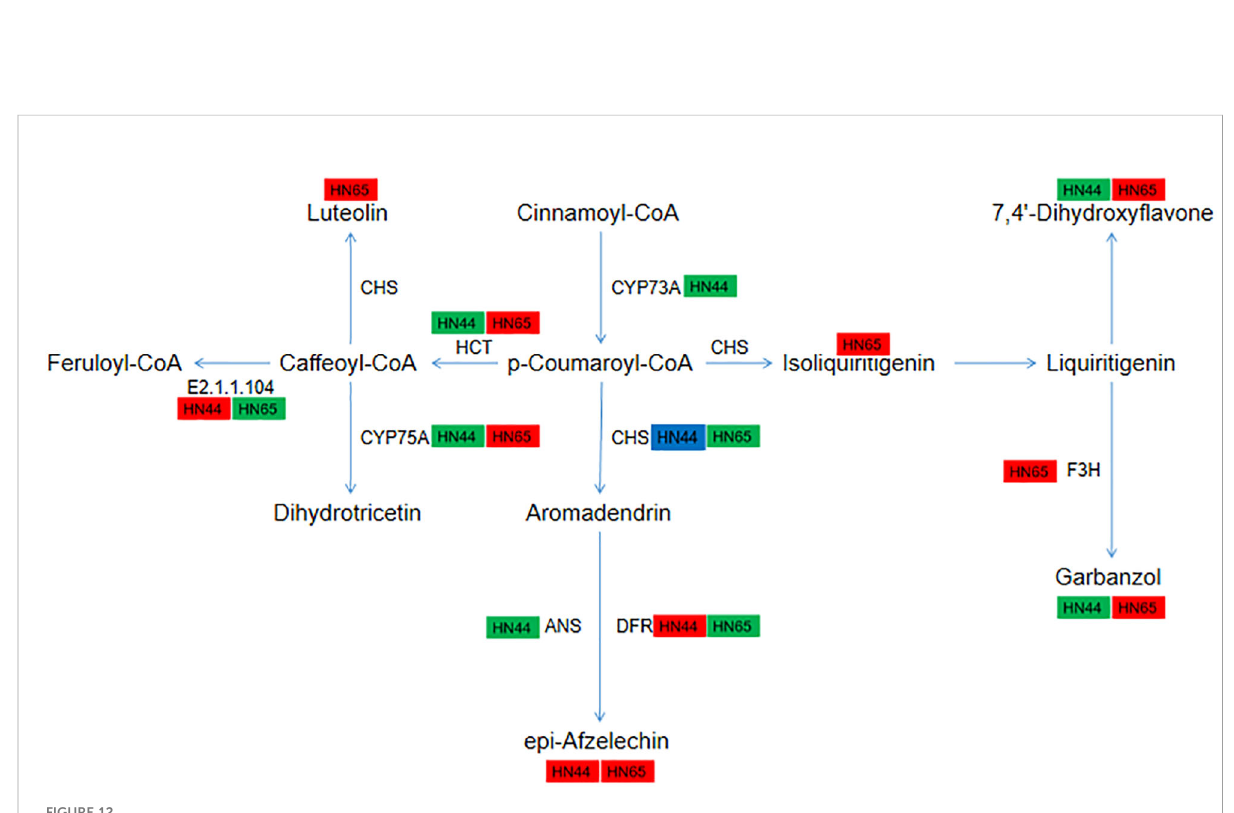
FIGURE 12 Pathway diagram of fl avonoid synthesis.